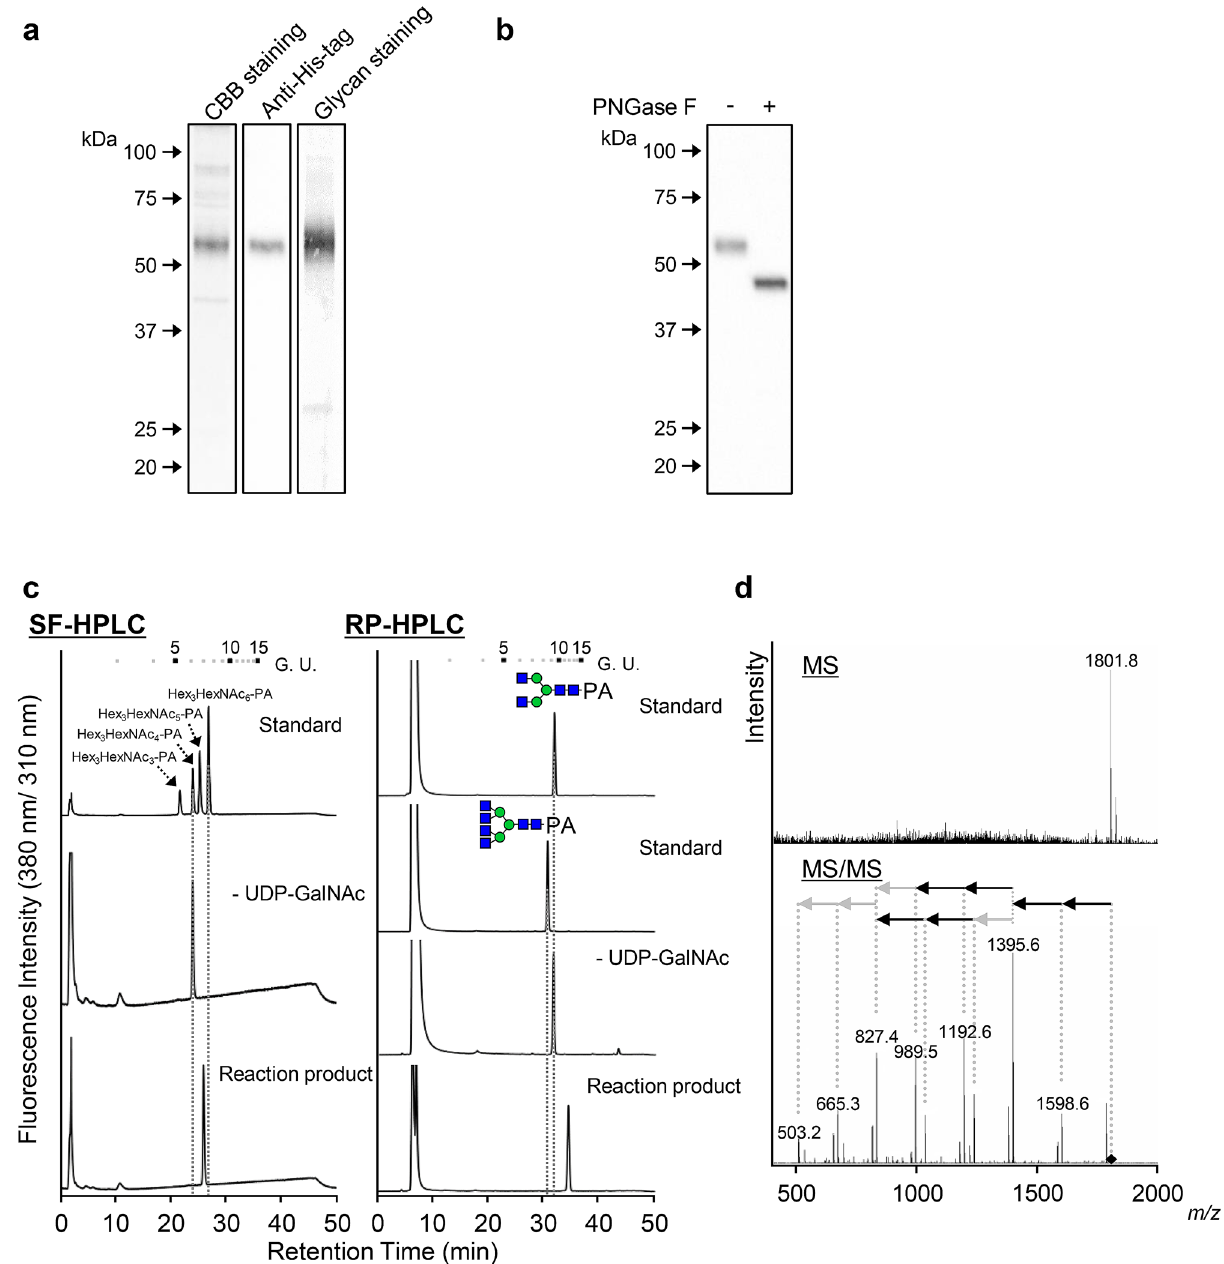
Figure 2. Analysis of the reaction products of BmGalNAcT. ( a ) CBB staining, His-tag staining, N -glycoprotein staining, and ( b ) de-glycosylation analysis of purified BmGalNAcT. Black and white triangles indicate the purified N -glycosylated form and de-glycosylated BmGalNAcTs, respectively. ( c ) SF- and RP-HPLC analysis of the reaction products. BmGalNAcT reaction was carried out using UDP-GalNAc and GN2M3 as a donor and an acceptor substrate, respectively. The elution position of the product was compared with authentic PA-sugar chains. Numbers at the top represent the elution positions of glucose units on the basis of the elution times of PA-isomalto-oligosaccharides with degrees of polymerization from 3 to 15. Green circles and blue boxes indicate Man and GlcNAc, respectively. ( d ) MS and MS/MS analysis of the reaction product. The MS signal represents (M + H) + ions of the reaction product. The value of m/z 503 detected in the MS/MS spectra agrees with the calculated mass of HexNAc 2 -PA. The mass of the precursor ion, m/z 1801.8, was considered to correspond to